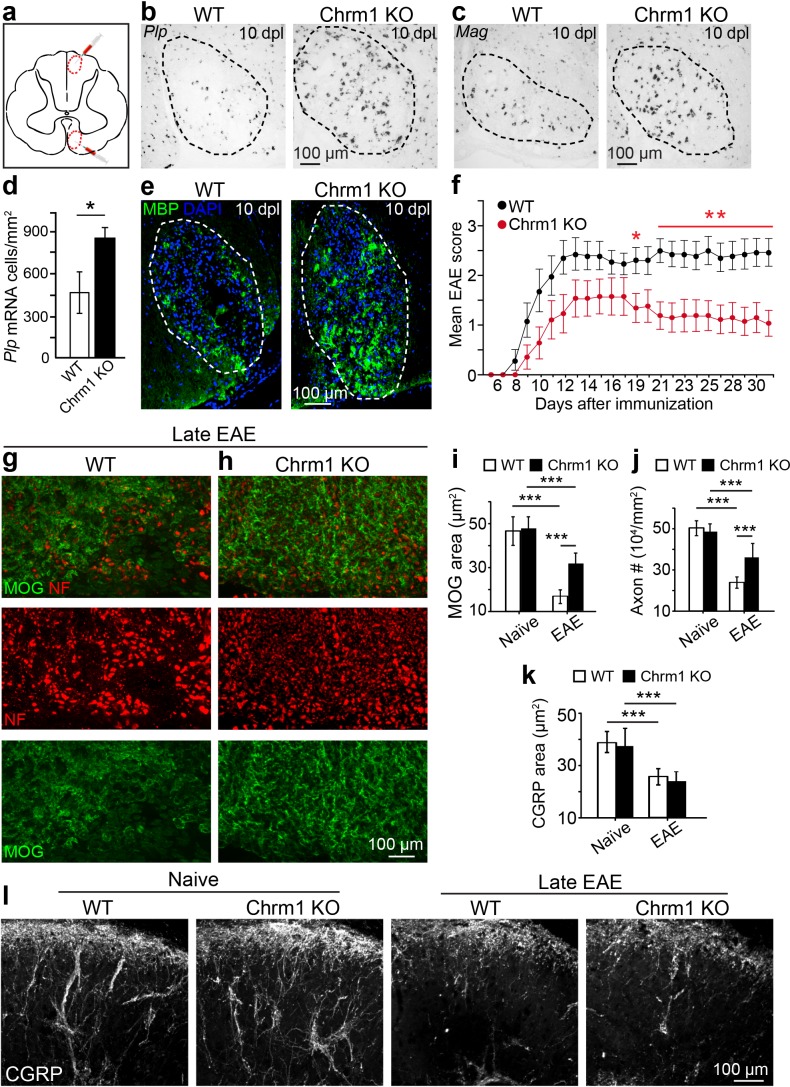
Chrm1 deletion accelerates remyelination and attenuates EAE clinical scores.(a) Schematic diagram displays the focal demyelinated lesions in the dorsal funiculus and ventrolateral white matter of mouse spinal cord. (b–e) Mice were analyzed by in situ hybridization of Plp (b) or Mag (c) and by MBP staining (e) at 10 days post lesion (dpl). (d) Quantification of Plp in situ hybridization displays a two-fold increase in Plp positive OLs. Error bars represent mean ± s.d. (4 animals in each group), and all experiments were performed in quadruplicate. (f) The clinical severity in MOG35-55 induced EAE was reduced in Chrm1 null mice (n = 14) as compared to sex matched wildtype (n = 15) littermates. Cumulative data shown represent mean ± s.e.m. from two independent experiments. Significance based on Mann-Whitney test for individual days, *p<0.05 or **p<0.01. (g, h) Spinal cord sections immunostained for MOG (green) and NF (red) showing myelin and axonal staining in wildtype and Chrm1 null mice. (i, j) Quantification of MOG+ areas (i) and NF+ axons (j) from Chrm1 knockout and wildtype mice with or without EAE induction. (k) Quantification of CGRP+ areas in the dorsal spinal cord from Chrm1 knockout and wildtype mice. (l) Staining and quantification of CGRP+ fibers in Chrm1 knockout and wildtype mice before and after EAE. Error bars (k) represent mean ± s.e.m. (from 3 representative animals in each group) and all experiments were performed in triplicate. *p<0.05; ***p<0.001, significance based on Student’s t-test with the respective controls.